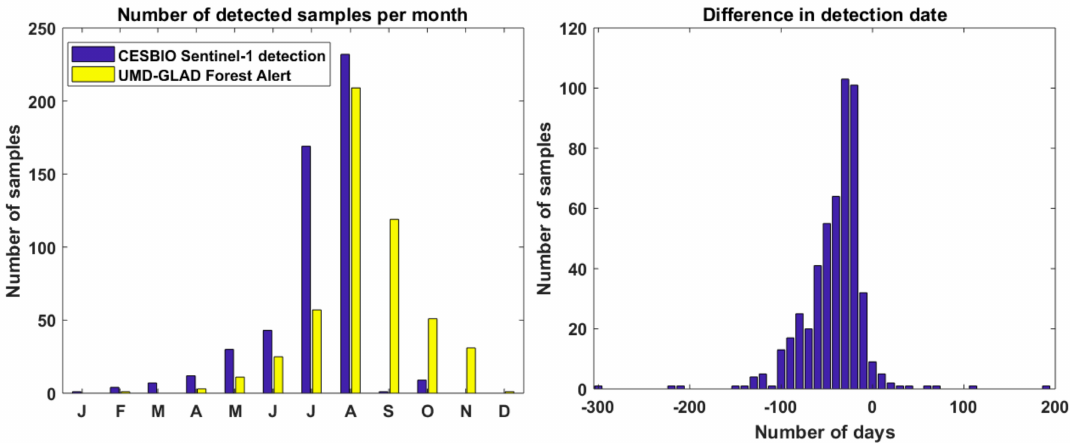
Figure 15. Number of detected reference samples per month for the S1-only method and for the UMD-GLAD Forest Alert system ( left ), and histogram of the difference in detection date of the reference samples ( right ), where negative values indicate an earlier detection in the S1-only method.